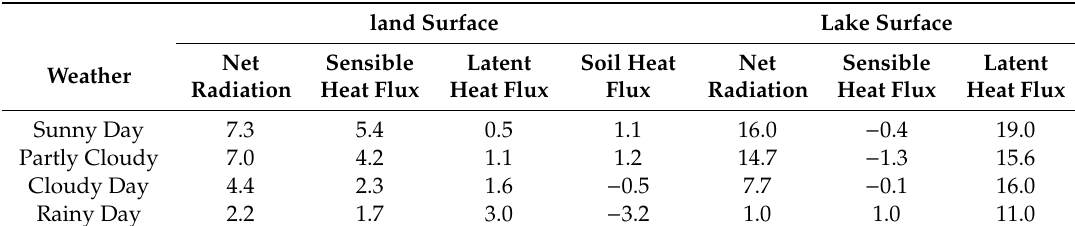
Table 4. Daily integral value of the energy flux on land and lake surface under different weather conditions (MJ · m − 2 ) (Ma et al., 2015).